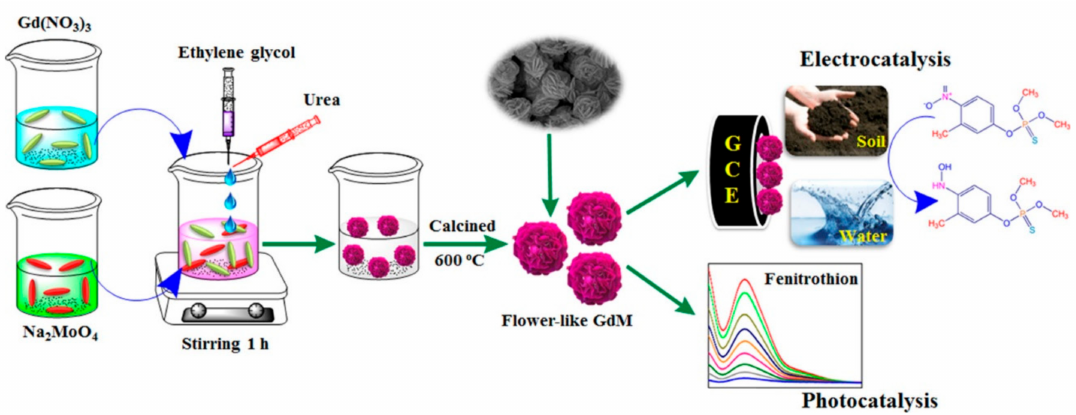
Figure 9. Overall synthesis procedure of flower-likeGDM and its electrocatalytic and photocatalytic applications. Repro- duced with permission of ACS from